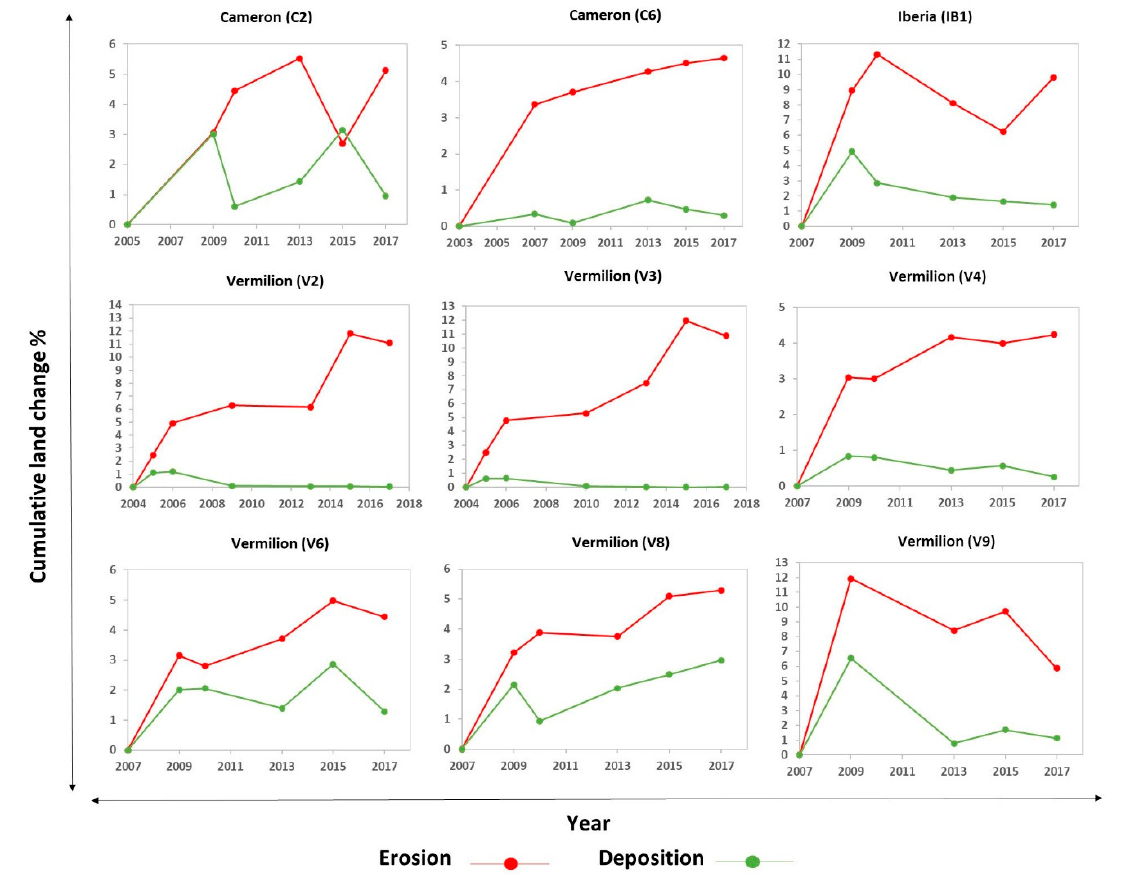
Figure 6. Land change trends of marsh terrace fields showing predominant erosion over time.